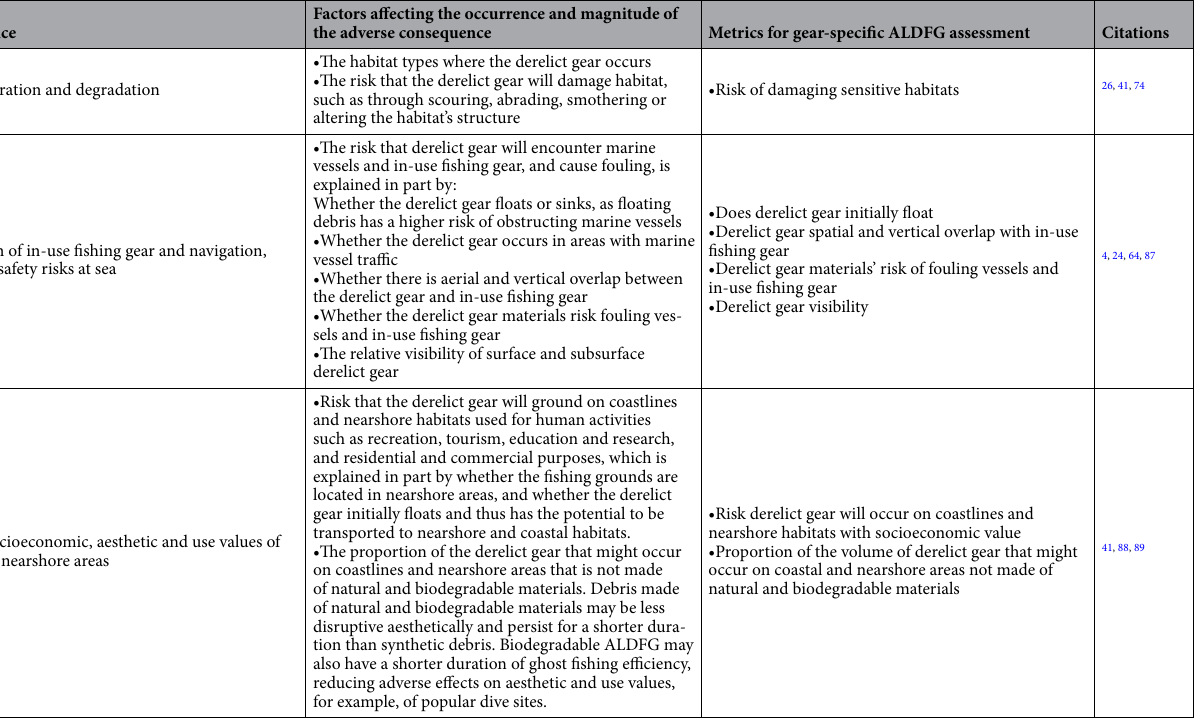
Table 1. Adverse consequences of ALDFG, factors that determine whether the adverse effect occurs and the severity of the effect, and metrics for gear-specific